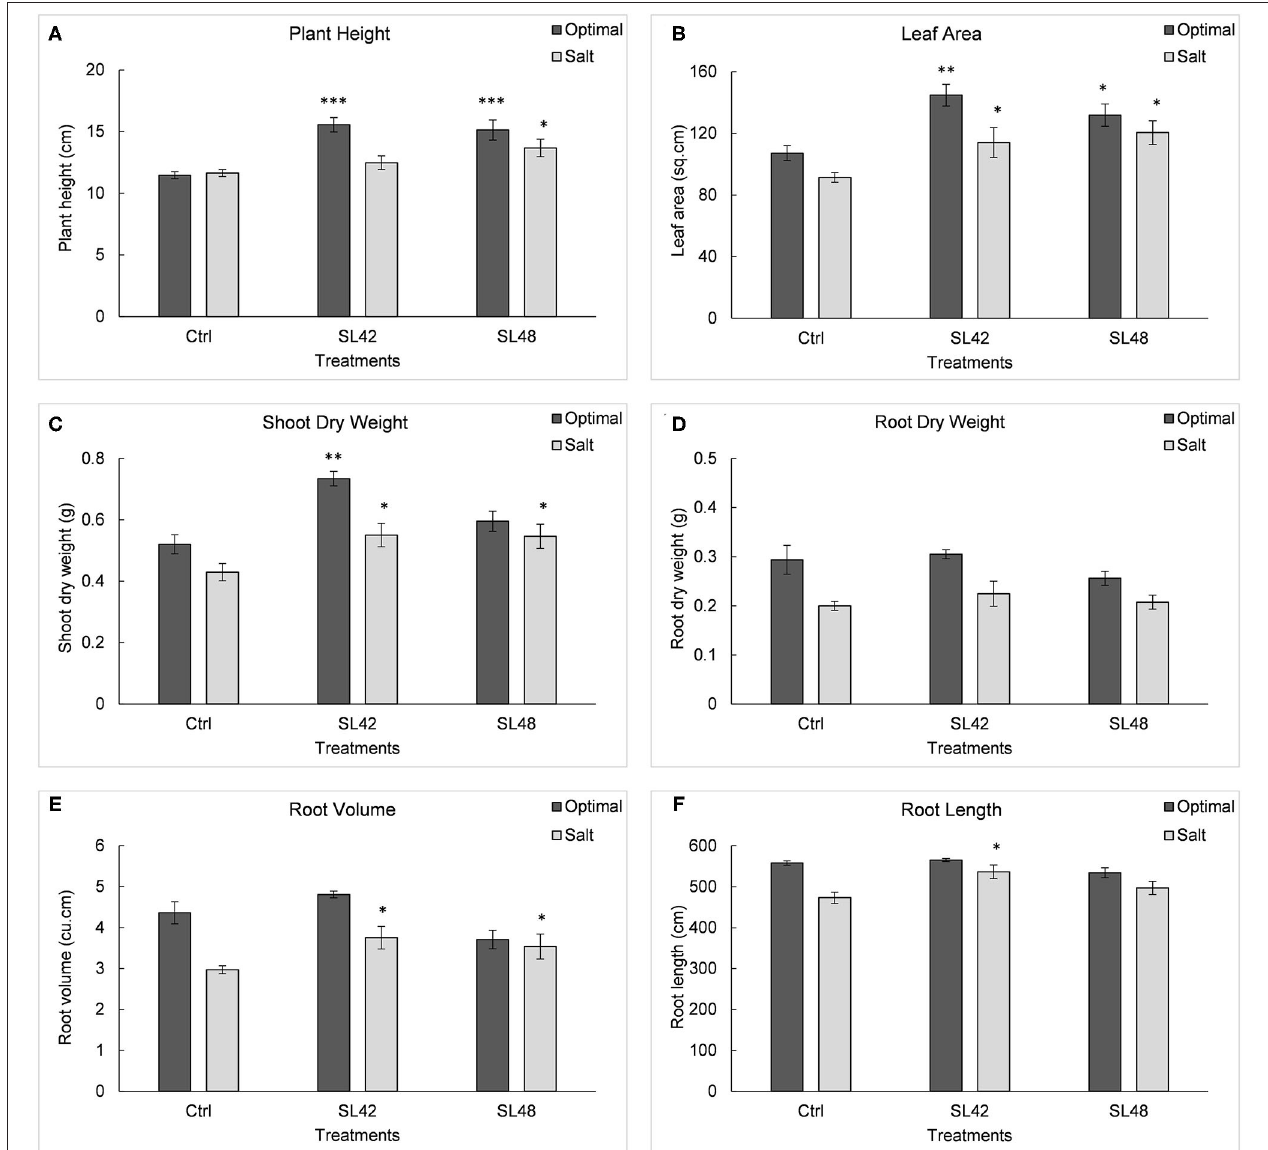
FIGURE 3 | Growth variables of soybean, (A) Plant height, (B) Leaf area index, (C) Shoot dry weight, (D) Root dry weight, (E) Root volume, and (F) Root length measured at 28 th DAP under optimal (water) and salt (100mM NaCl) conditions. The seeds were treated with 10mM MgSO 4 as control or bacterized with strains SL42 and SL48. Values represent mean ± SE ( n = 6). Significant differences (increase) between the bacterial treatments and the respective control treatments (optimal or salt) are indicated by asterisk above the data points, * p ≤ 0.05, ** p ≤ 0.001, *** p ≤ 0.0001 ( α =